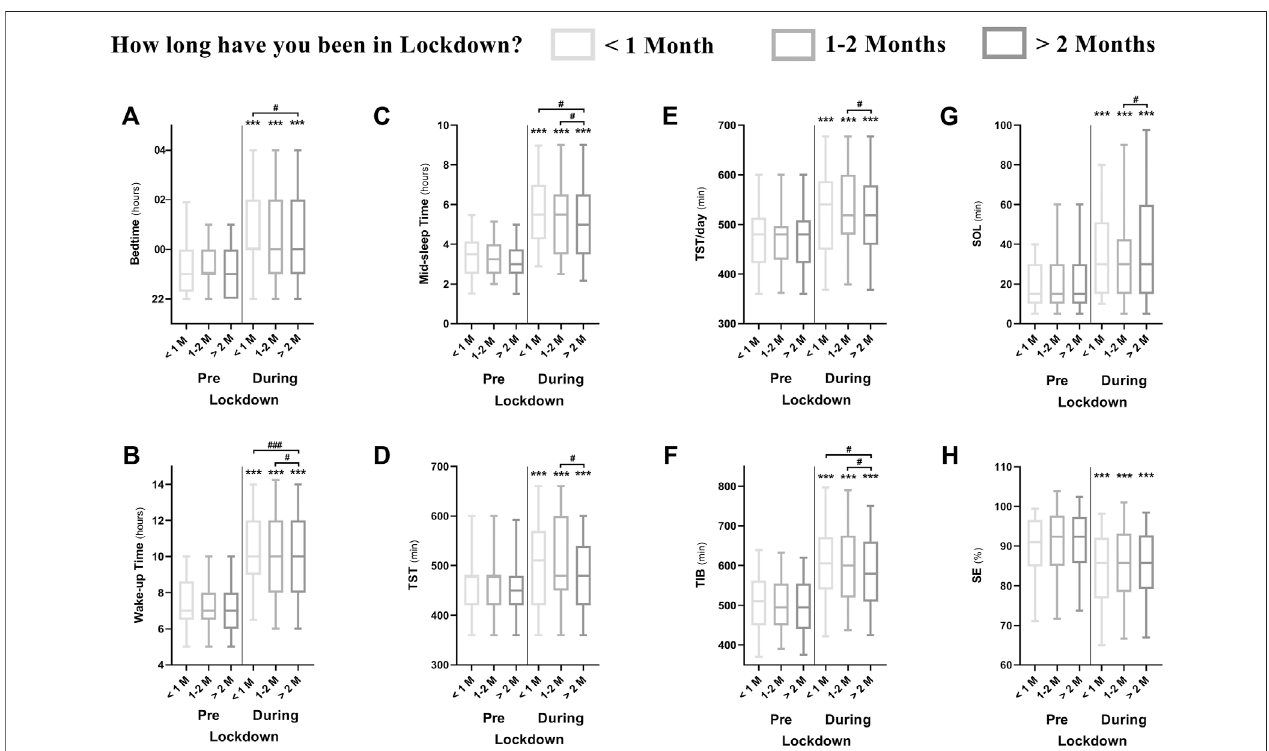
FIGURE 5 | Difference between athletes who were in lockdown for < 1 month ( n = 222), 1 – 2 months ( n = 389) and > 2 months ( n = 843) during-compared to pre- lockdown in different sleep metrics; (A) Bedtime; (B) wake time; (C) mid-sleep time; (D) total sleep time; (E) total sleep time per 24 h; (F) time in bed; (G) sleep onset latencyand (H) sleepef fi ciency.*,**and***meanssigni fi cantwithinsubjecteffectofthelockdownat p < 0.05, p < 0.01and p < 0.001,respectively.#,##and###means signi fi cant between subject effect during-lockdown at p < 0.05, p < 0.01 and p < 0.001, respectively. Signi fi cance is assessed by a mixed design ANOVA and the Bonferroni post-hoc